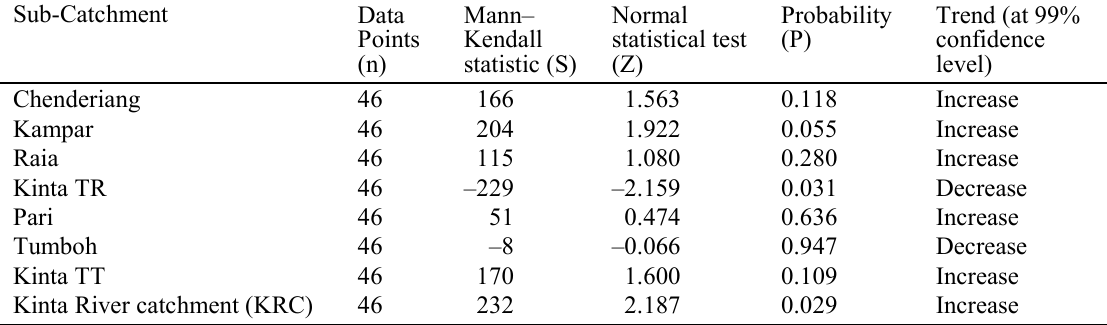
Table 3 Mann–Kendall test analysis for annual discharge trend for Kinta River catchment and sub- catchments, 1961–2006.